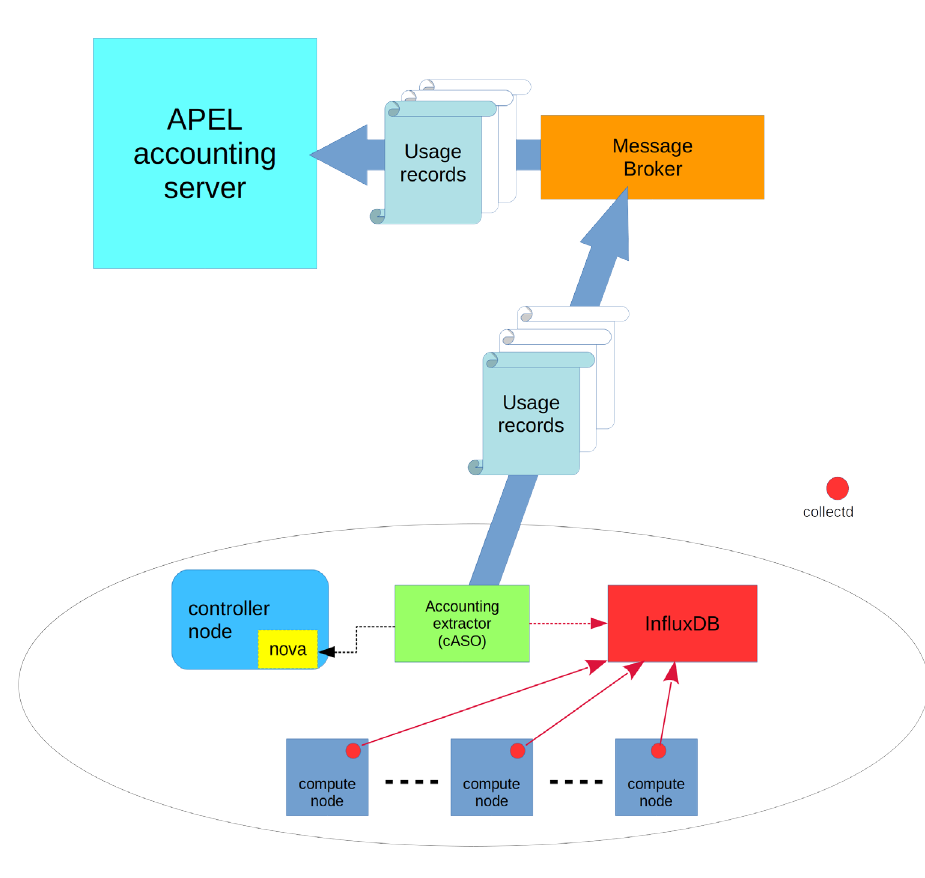
Figure 3. Architecture of CloudVeneto accounting